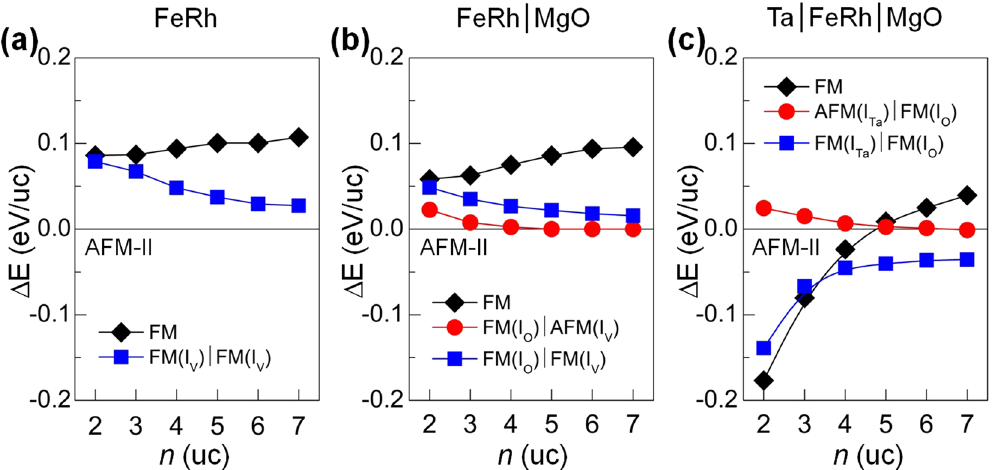
Figure 2. Relative energy Δ E versus the numbers of FeRh unit cell layers ( n ) for the different magnetic structures shown in Fig. 1 with respect to the AFM-II phase for ( a ) FeRh, ( b ) FeRh/MgO, and ( c ) Ta/FeRh/MgO multilayers.